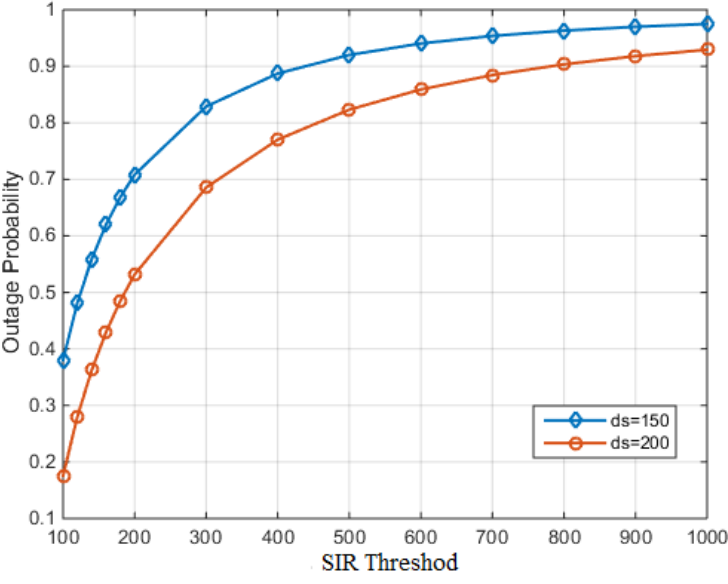
Figure 9. The transmission opportunity with highest priority versus predefined carrier sensing threshold.